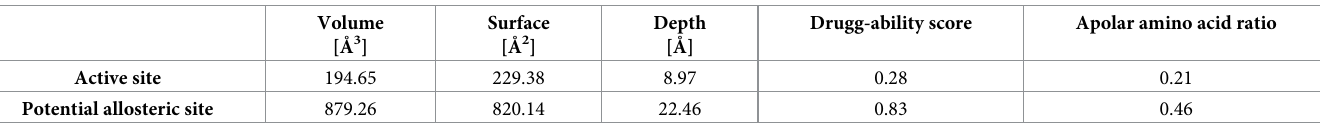
Table 2. Shape description and druggability prediction of the active and the potential allosteric site of GMII using DoGSiteScorer (PDB code: 1HWW